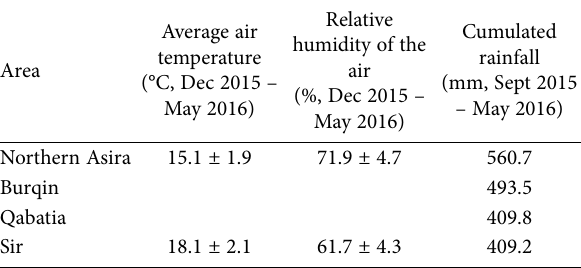
Table 1. Climatic data of the experimental sites in Palestine exam- ined in this study. Temperature and relative humidity values are means ± standard